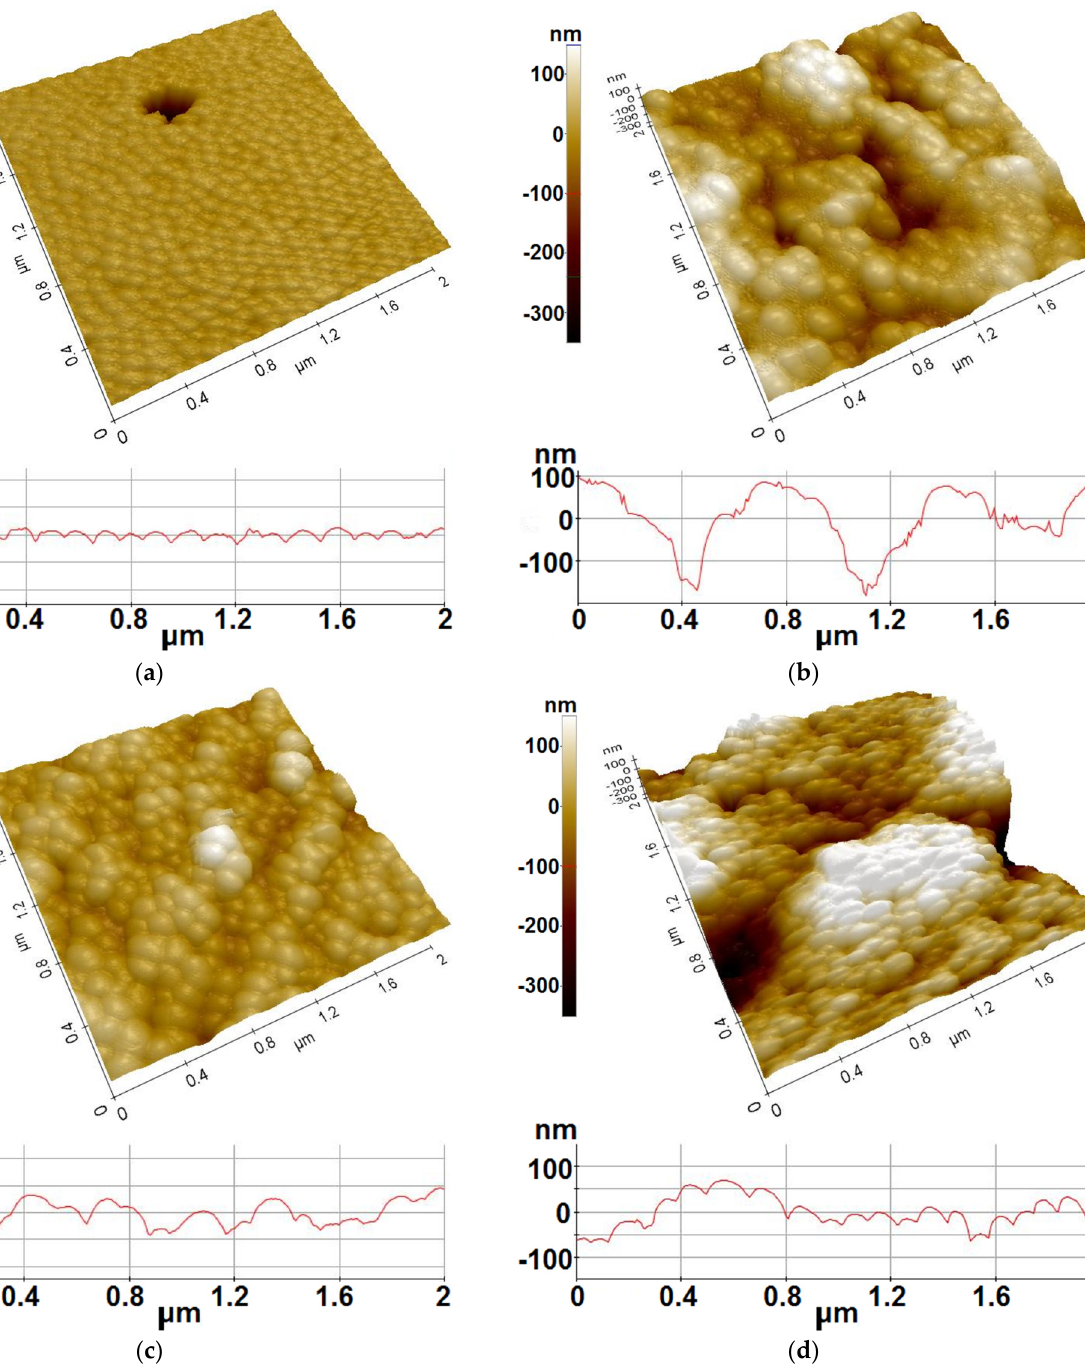
Figure 6. AFM images of silica and organically modified silica. SiO 2 -1 ( a ), SiO 2 -1-Org1 ( b ), SiO 2 -1-Org2 ( c ), and SiO 2 -1- Org3 ( d ).